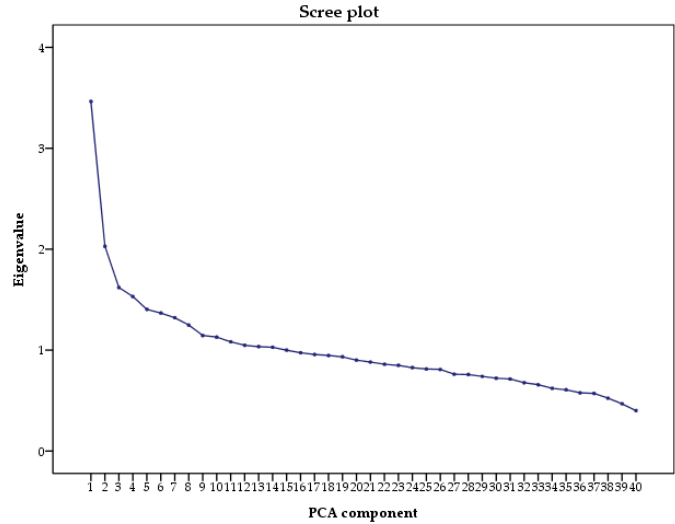
Figure 1. Scree plot of the eigenvalues. We used the scree plot examination to determine the appropriate number of dietary pattern. Scree plot represents the partitioning of the total variation (i.e., eigenvalue) accounted for each principal component, against the principal component number. PCA: principal component analysis.